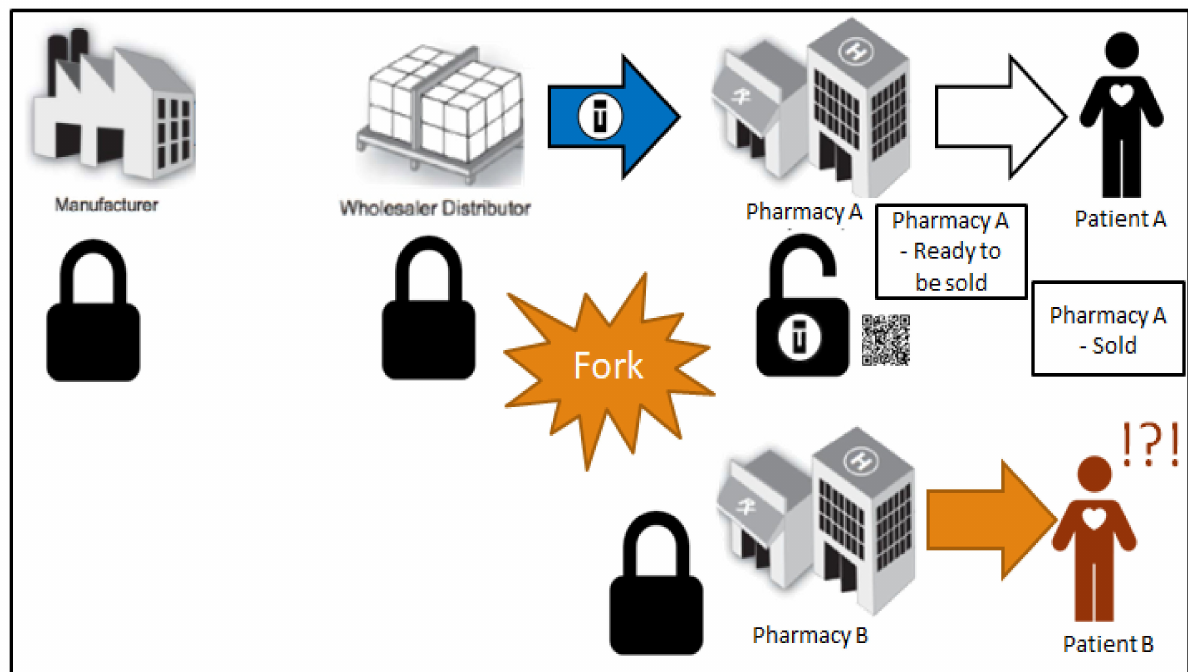
Figure 7. Use case of a counterfeit product that can be detected with NFT